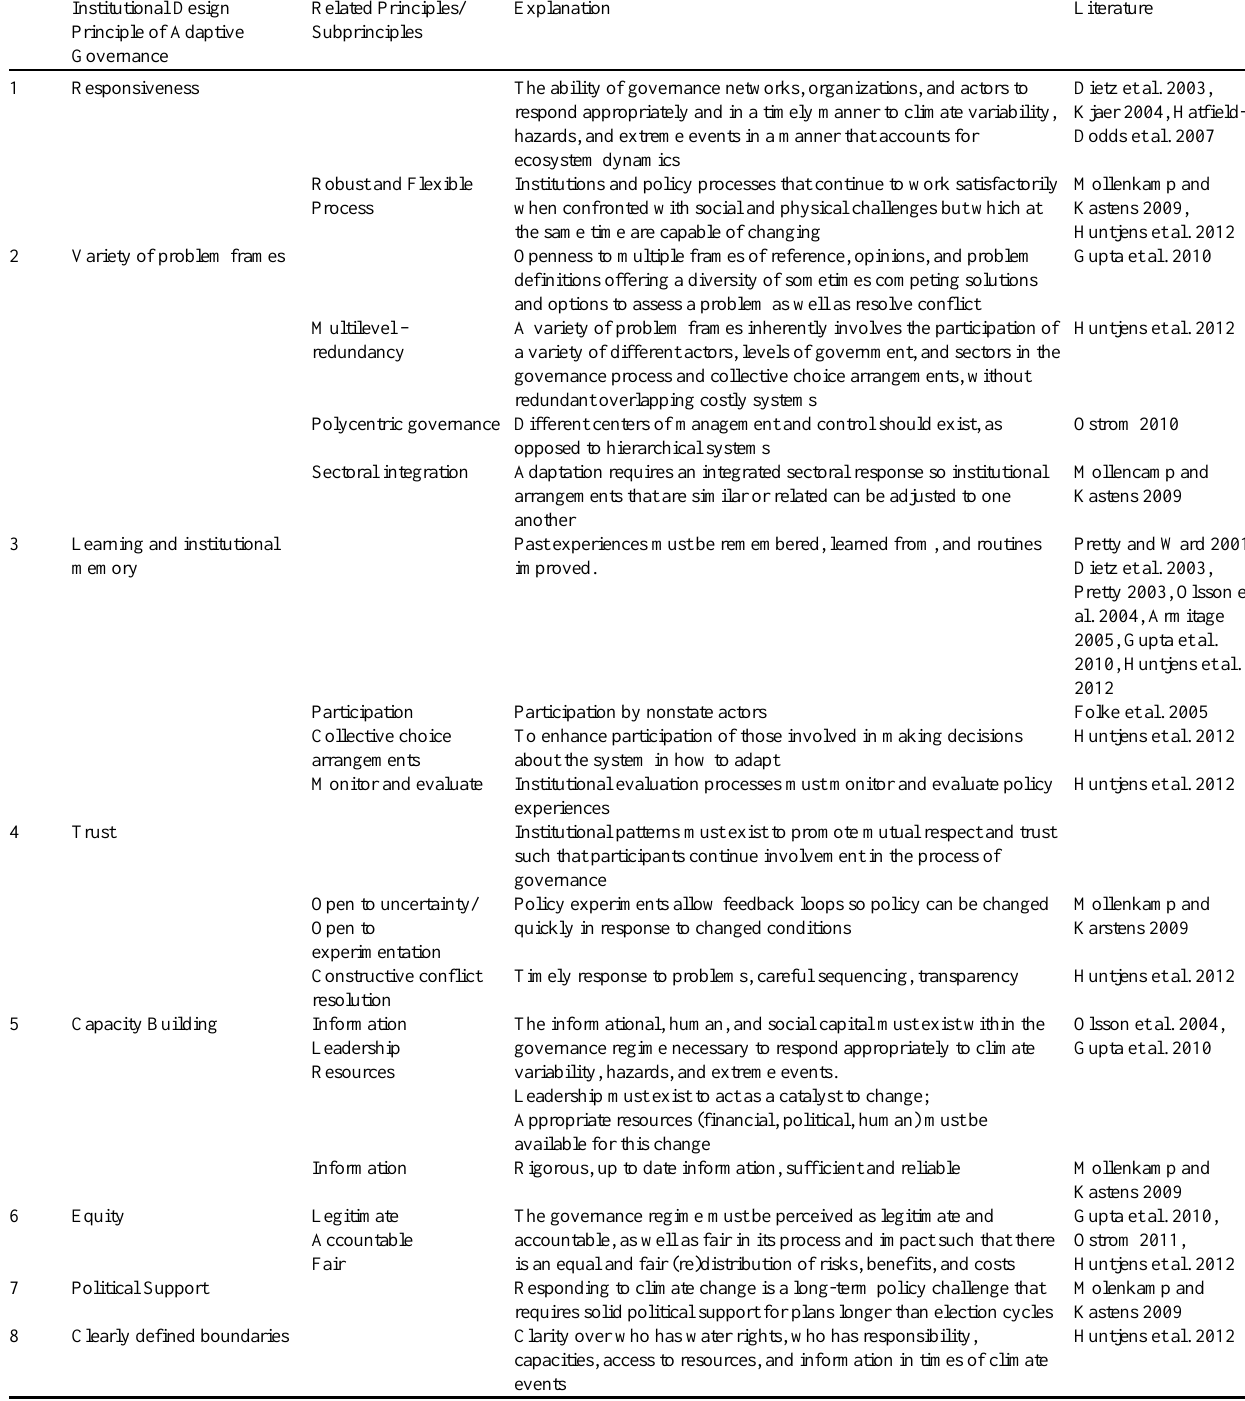
Table 1 . Dimensions of adaptive governance.